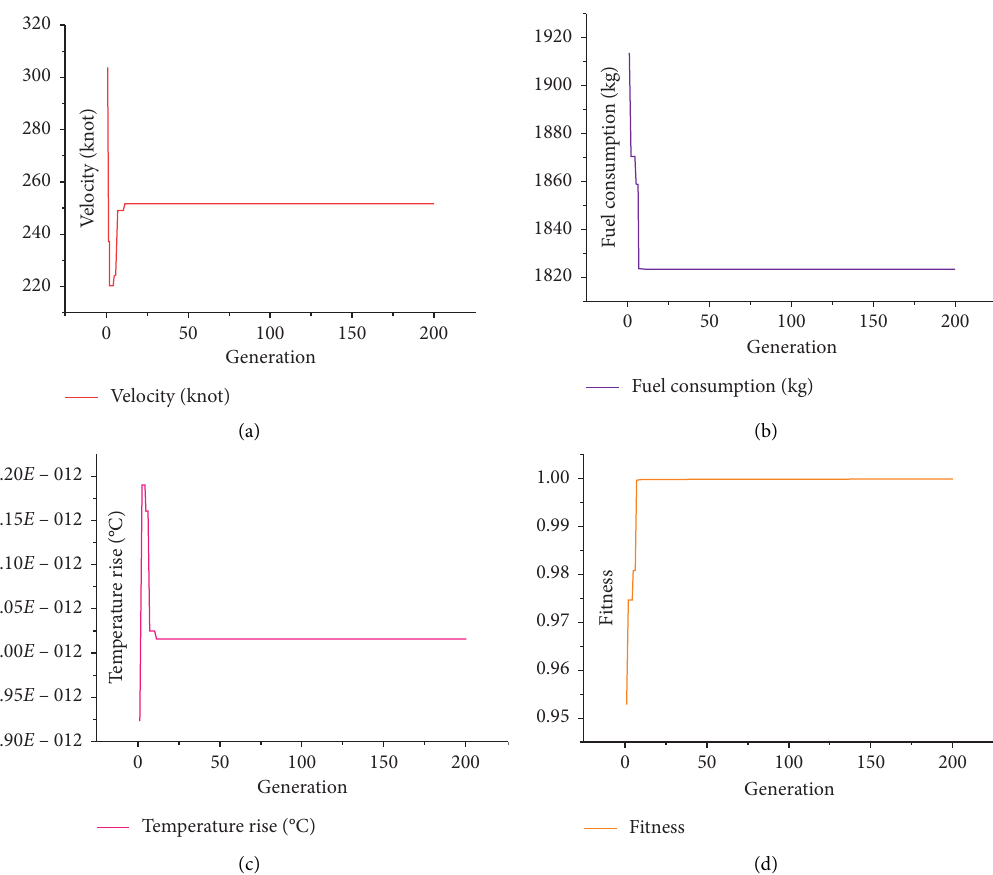
Figure 7: Optimization results with minimum fuel consumption without RTA time constraint.